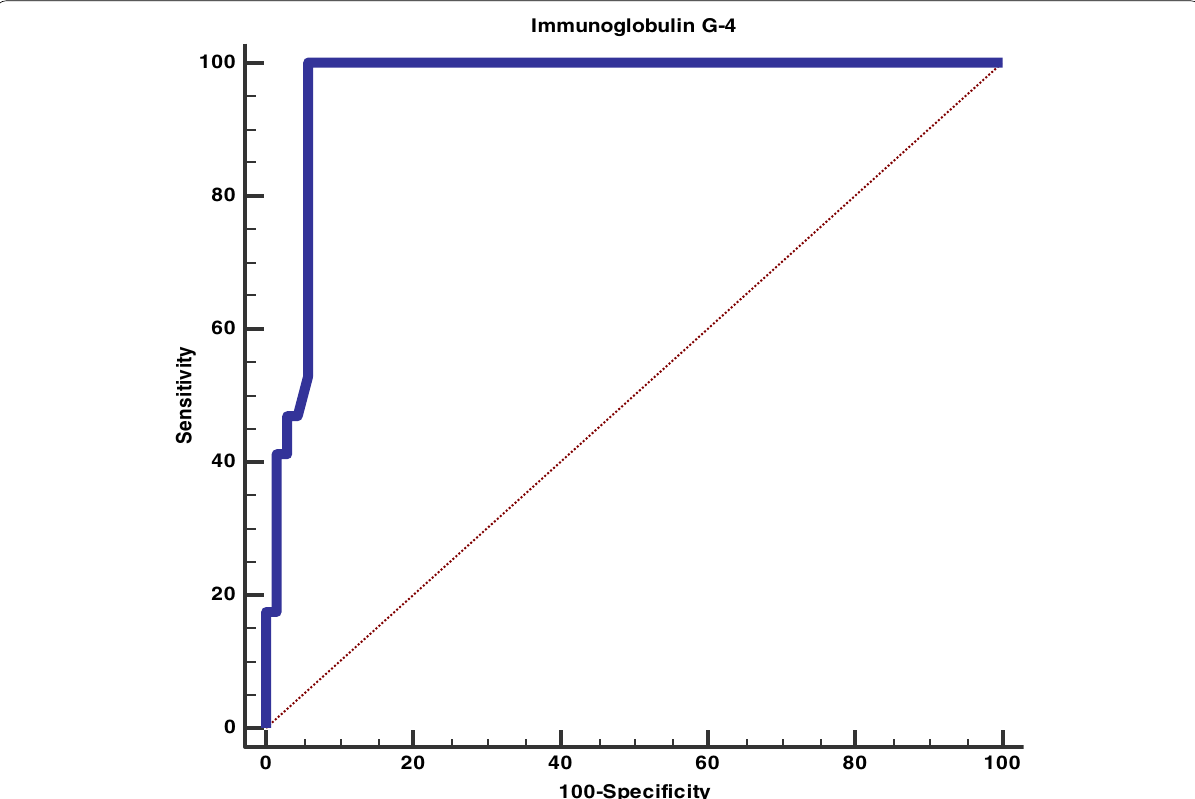
Fig. 1 Accuracy of serum level of IgG4 in diagnosis of pleural effusion secondary to lymphoplasmacytic infiltration. At cutoff point > 152 mg/dl; IgG‑4 had 100% sensitivity, and 94% specificity in diagnosis of pleural effusion secondary to IgG 4‑related effusion with overall accuracy was 95.3% and area under the